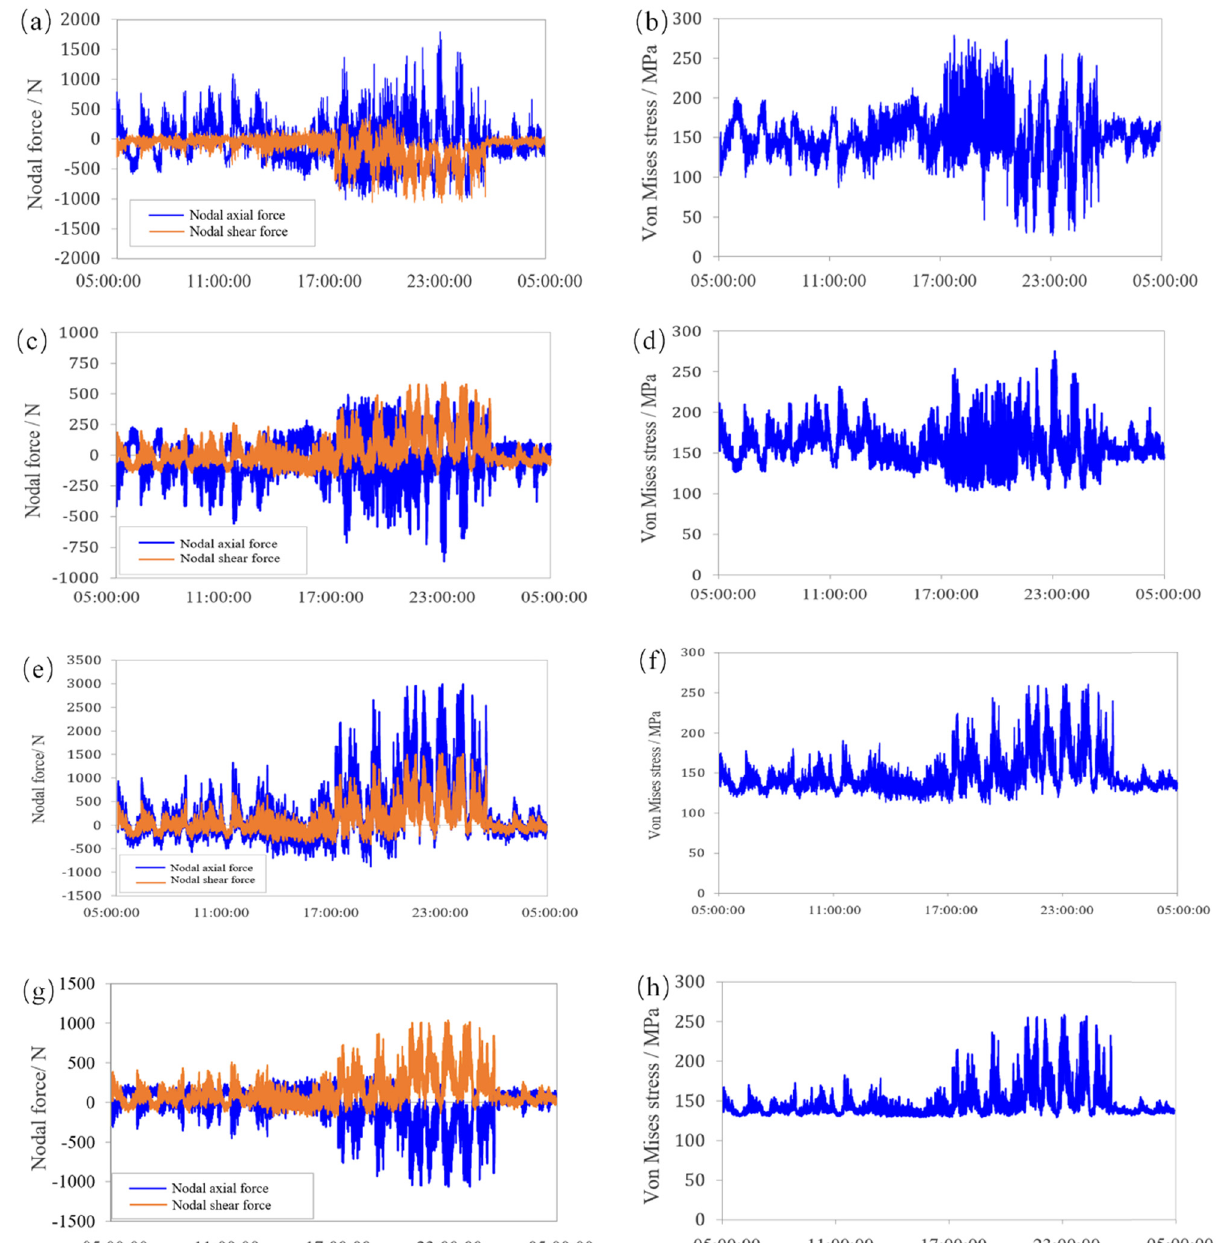
Figure 19: Time - history of nodal forces and SVM stress of connection components. ( a ) Nodal forces at contact clamp; ( b ) SVM at contact clamp; ( c ) nodal forces at messenger clamp; ( d ) SVM at messenger clamp; ( e ) nodal forces at support base ( bottom ) ; ( f ) SVM at support base ( bottom ) ; ( g ) nodal forces at bushing ears ( top frame anchor ) ; ( h ) SVM at bushing ears ( top frame anchor )